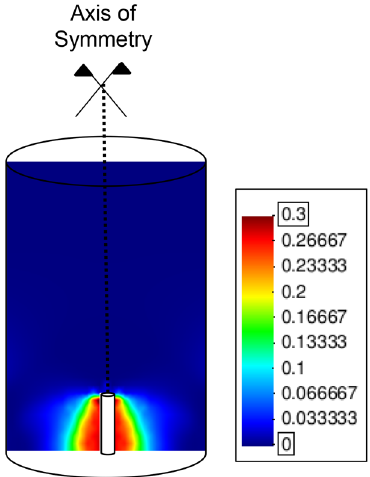
Fig. 15 Distribution of damage along the perforation wall at the end of the